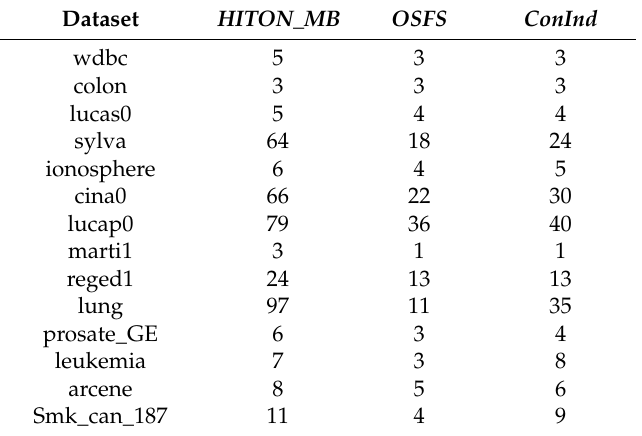
Table 9. The number of selected features of the three algorithms.